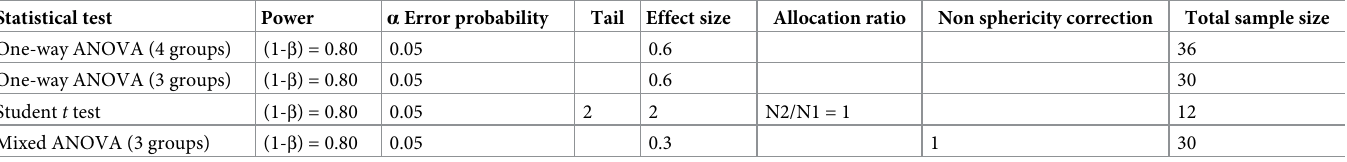
Table 1. Statistical tests and selected